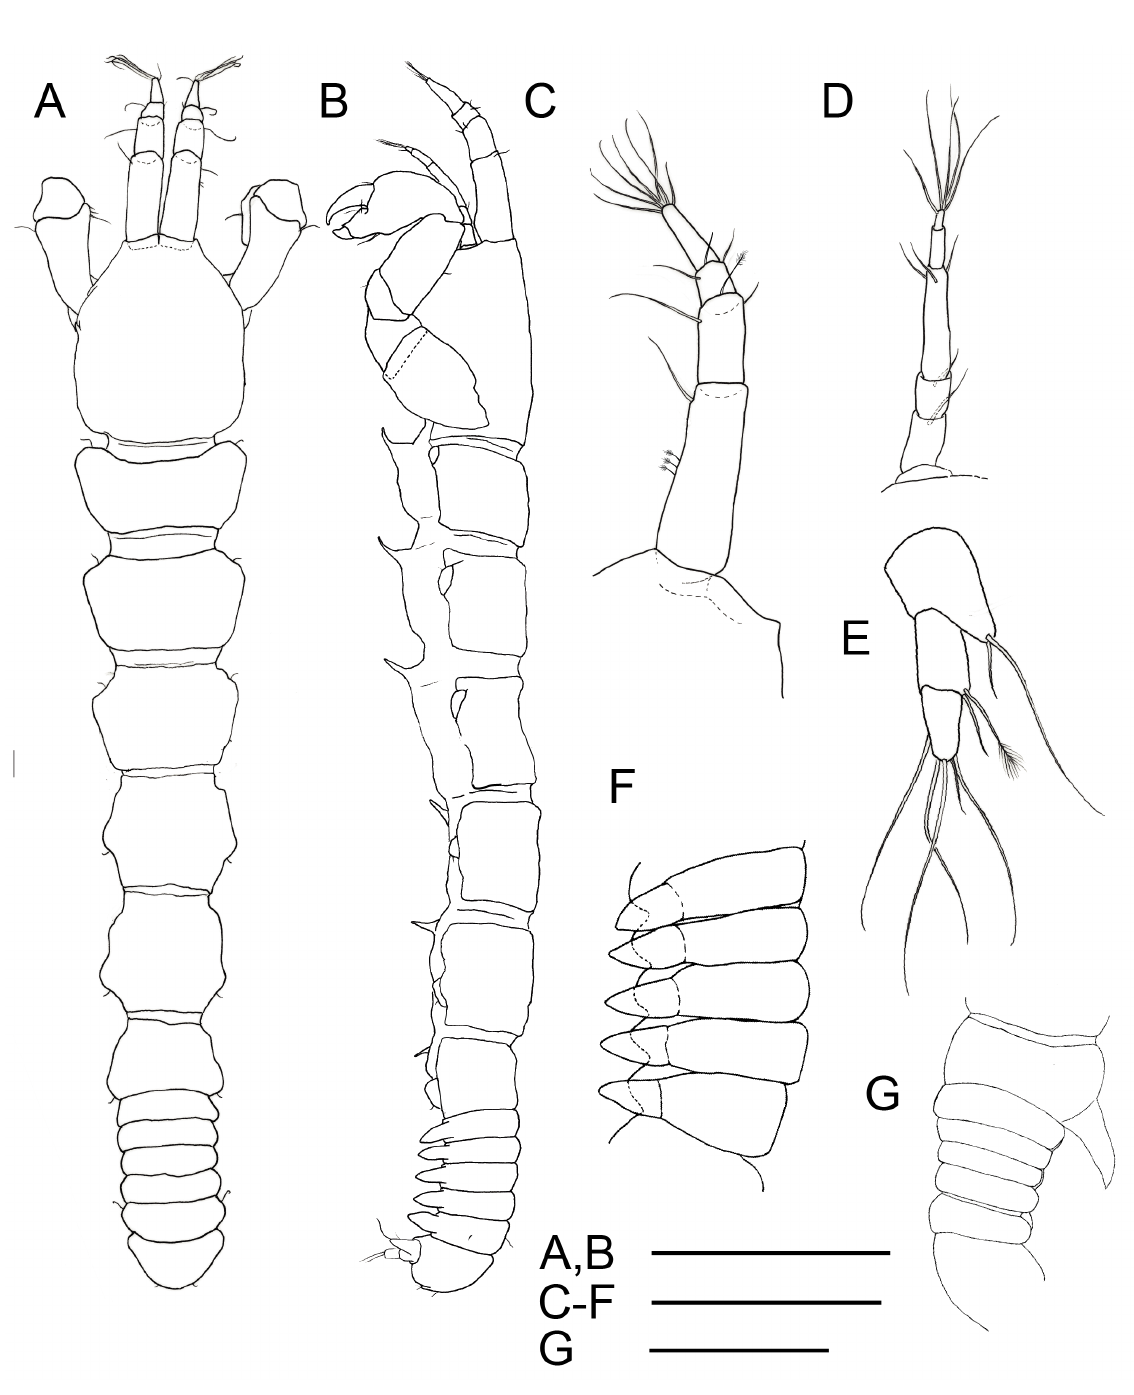
Fig. 2. Paranarthrura cousteaui sp. nov. A–E . Dissected paratype, adult, ♀ (DBUA0002189.03). A . Habitus dorsal view. B . habitus lateral view. C . Left antennule. D . Right antenna in ventral view. E . Left uropod. F–G . Dissected paratype, manca II (MNCN 20.04/125339). F . Detail of pleopods. G . Pleon. Scale bars: A–B = 500 μm; C–F = 100 μm; G = 50